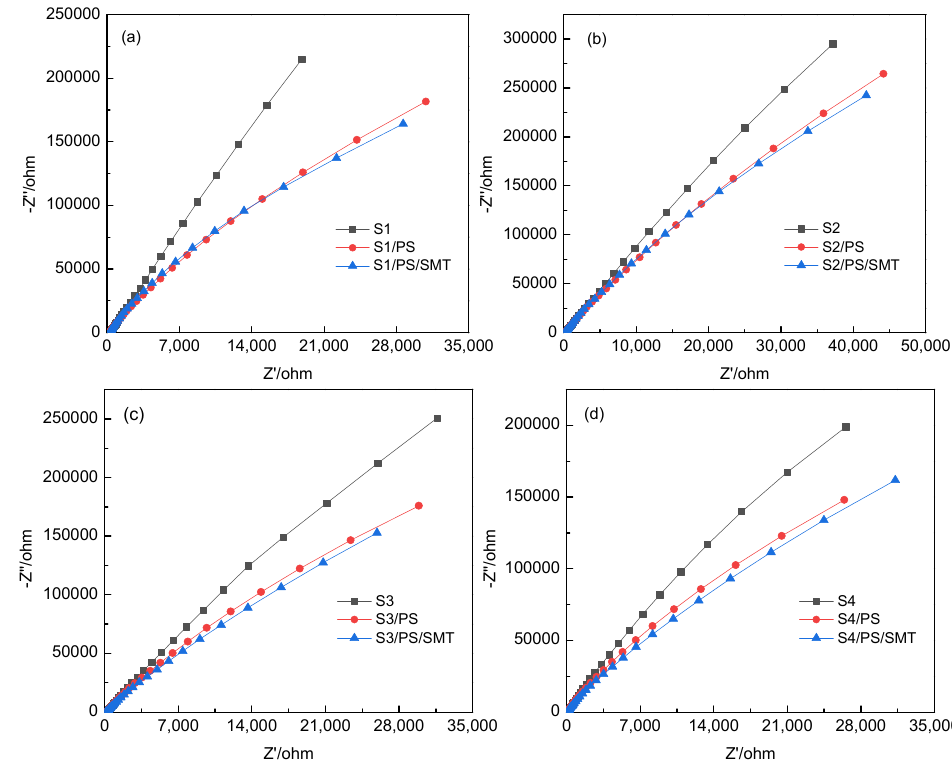
Figure 9. EIS images of ( a ) S1, ( b ) S2, ( c ) S3 and ( d ) S4. Reaction conditions: [SMT] 0 = 5 mg/L, [PS] 0 = 4 mM, [TM] 0 = 5 g/L, pH 0 = 5 and T = 25 °C. ( a ) was reproduced from Ref. [8] with permission from [PS] 0 = 4 mM, [TM] 0 = 5 g/L, pH 0 = 5 and T = 25 ◦ C. ( a ) was reproduced from Ref. [8] with permission Elsevier. from